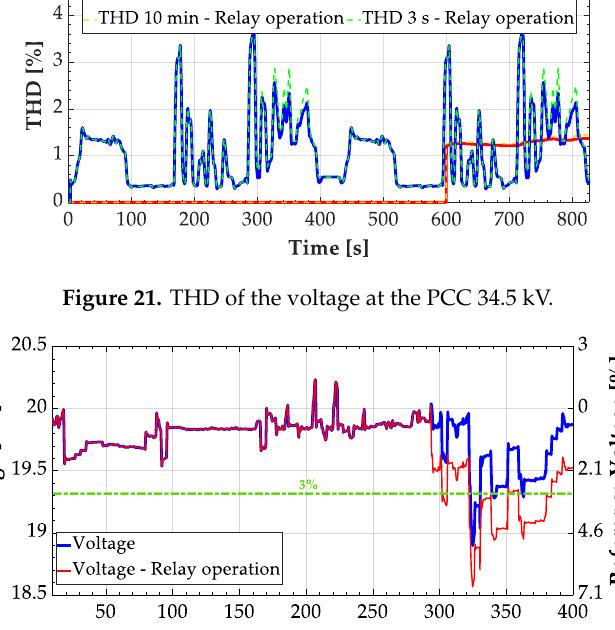
Figure 21. THD of the voltage at the PCC 34.5 kV. Figure 22. RMS phase voltage value and voltage drop at PCC. Figure 22. RMS phase voltage value and voltage drop at